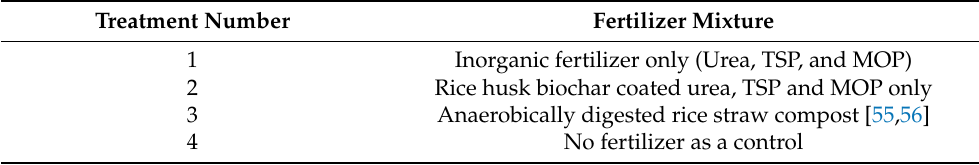
Table 5. Treatments were carried out in this